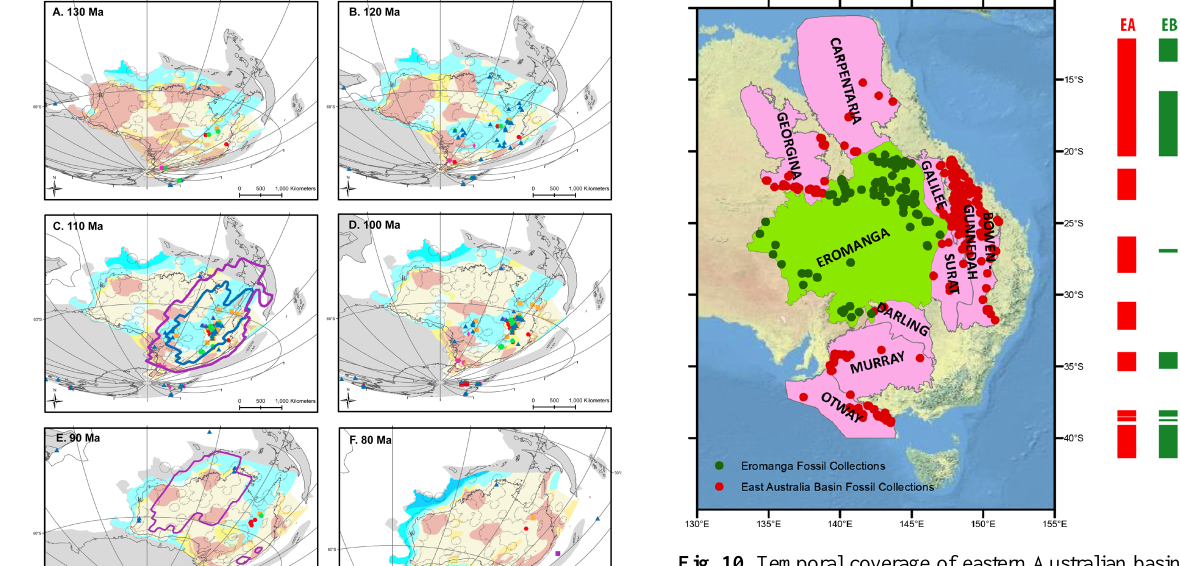
Fig. 10. Temporal coverage of eastern Australian basins (EA) and the Eromanga Basin (EB). Much of the sampled collections are on the outskirts of the Eromanga Basin with data gaps that may be related to sampling gaps, orogenic episodes and the influence of glaciations on eastern Australia during the late